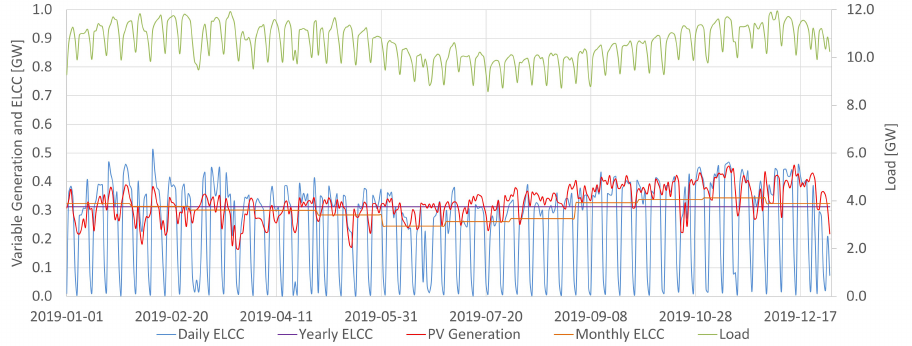
Figure 17. Daily, monthly and yearly ELCC for PV power in 2019 for the Northeast